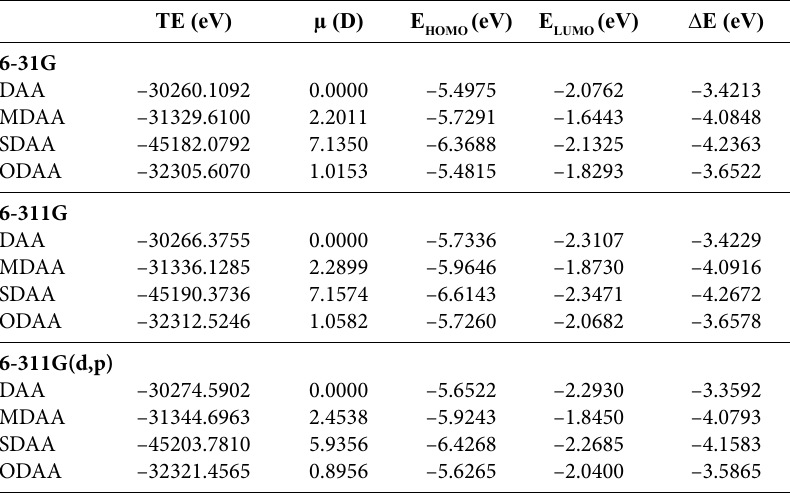
Table 1: Calculated quantum chemical descriptors for non-protonated molecules in gas phase.